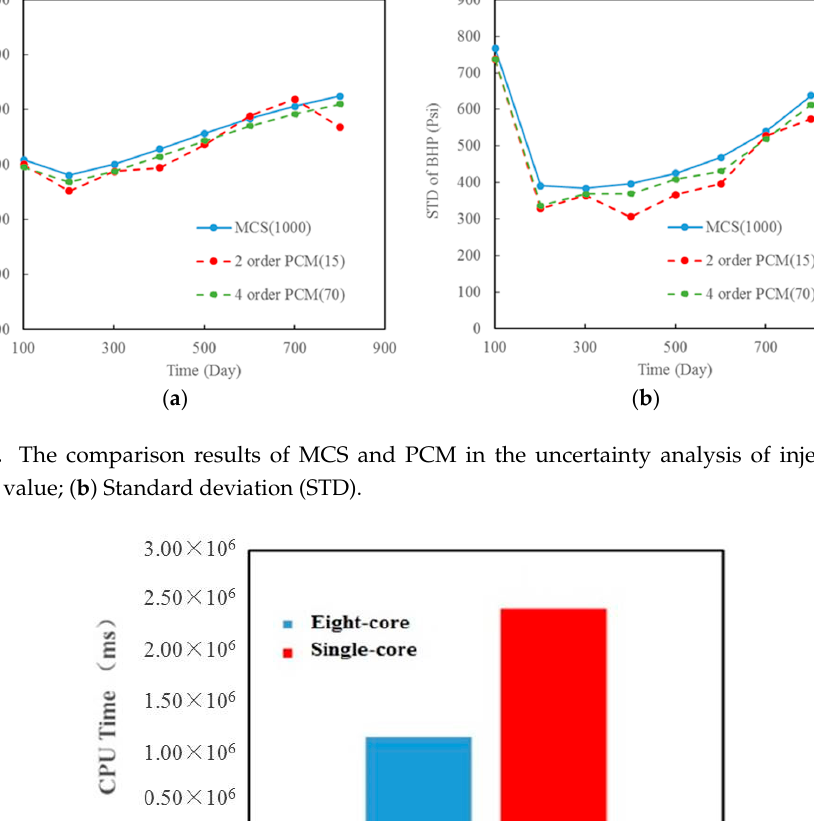
Figure 6. The comparison results of MCS and PCM in the uncertainty analysis of the producer bottom hole pressure (BHP). ( a ) Mean value; ( b ) Standard deviation (STD).